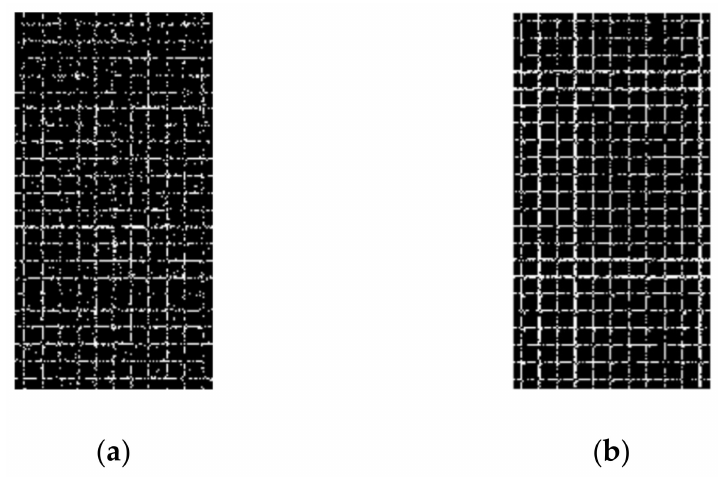
Figure 15. Canny results based on some pre-treatments of IV2 image: ( a ) saving IV2 image with